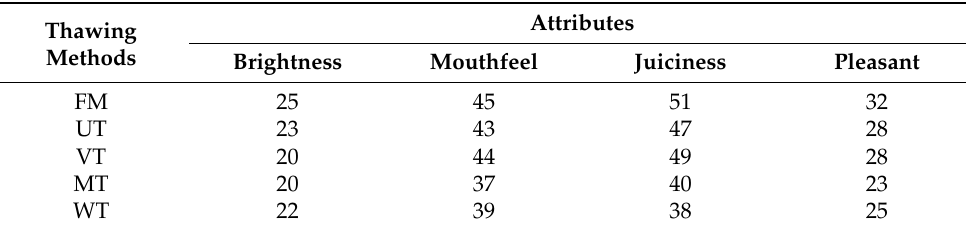
Table 7. Frequency mentioned attributes by porcine longissimus dorsi CATA for each sample.